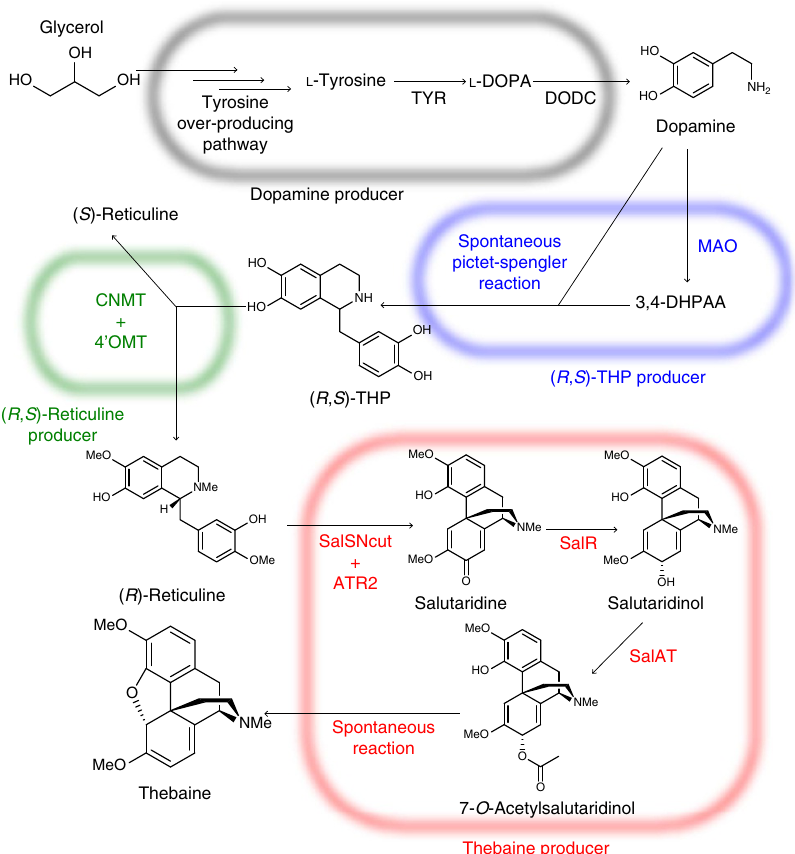
Figure 1 | Total biosynthesis of thebaine using four-step culture. The brackets indicate the reactions in the individual strain of each culture step. ATR2, NADPH-cytochrome P450 reductase 2; CNMT, coclaurine N -methyltransferase; DODC, dopa decarboxylase; MAO, monoamine oxidase; SalSNcut, N-terminally-truncated salutaridine synthase; SalR, salutaridine reductase; SalAT, salutaridinol acetyltransferase; TYR, tyrosinase; 3,4-DHPAA, 3,4- dihydroxyphenylacetaldehyde; 4 0 OMT, 3 0 -hydroxy- N -methylcoclaurine 4 0 - O